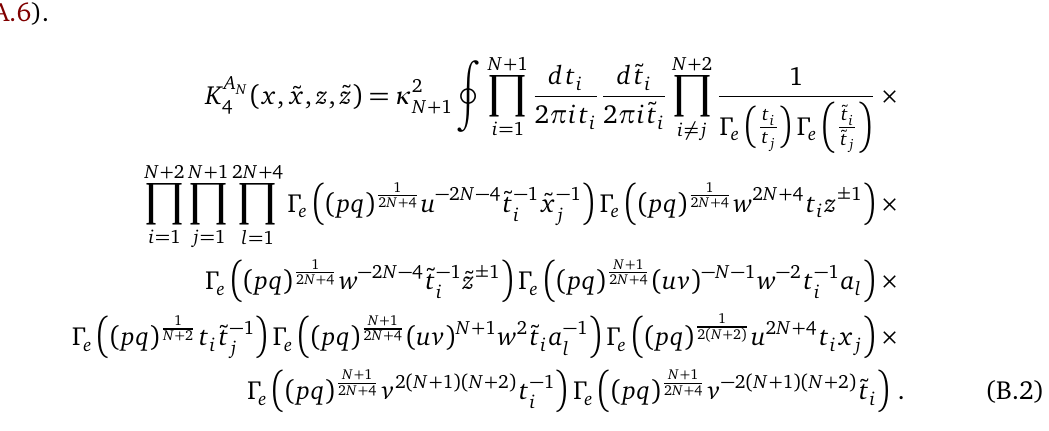
trinions. Red lines correspond to the N